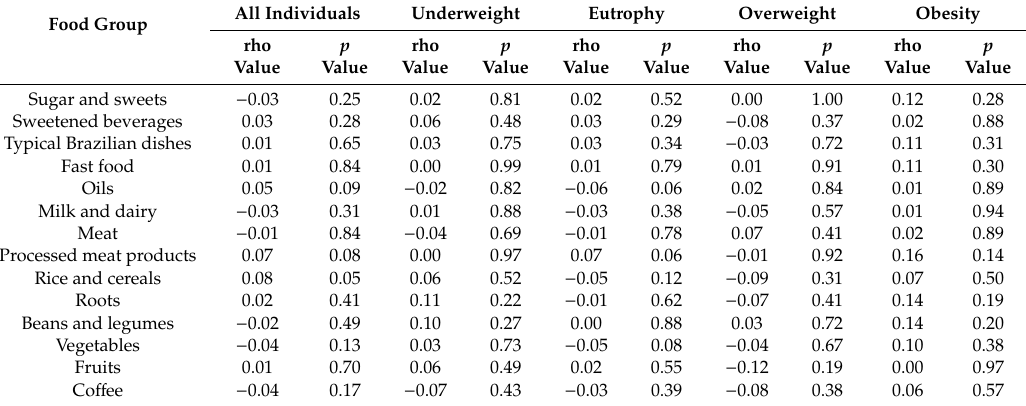
Table 4. Spearman correlation analysis between total consumption of each food group and BMI values. All Individuals Underweight Eutrophy Overweight Obesity Food Group p p rho rho Value Value Value